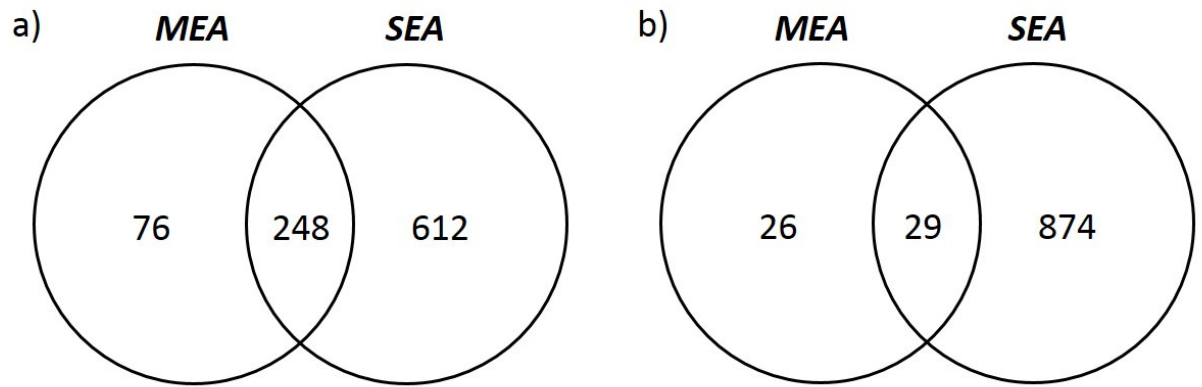
Figure 3. Common DE genes between MEA- and SEA-affected horses. Venn diagrams showing the number of common differentially expressed genes between MEA- and SEA-affected horses. MEA: pairwise comparison between the MEA and CTRL groups. SEA: pairwise comparison between the SEA and CTRL groups. ( a ) Upregulated transcripts; ( b ) downregulated transcripts.